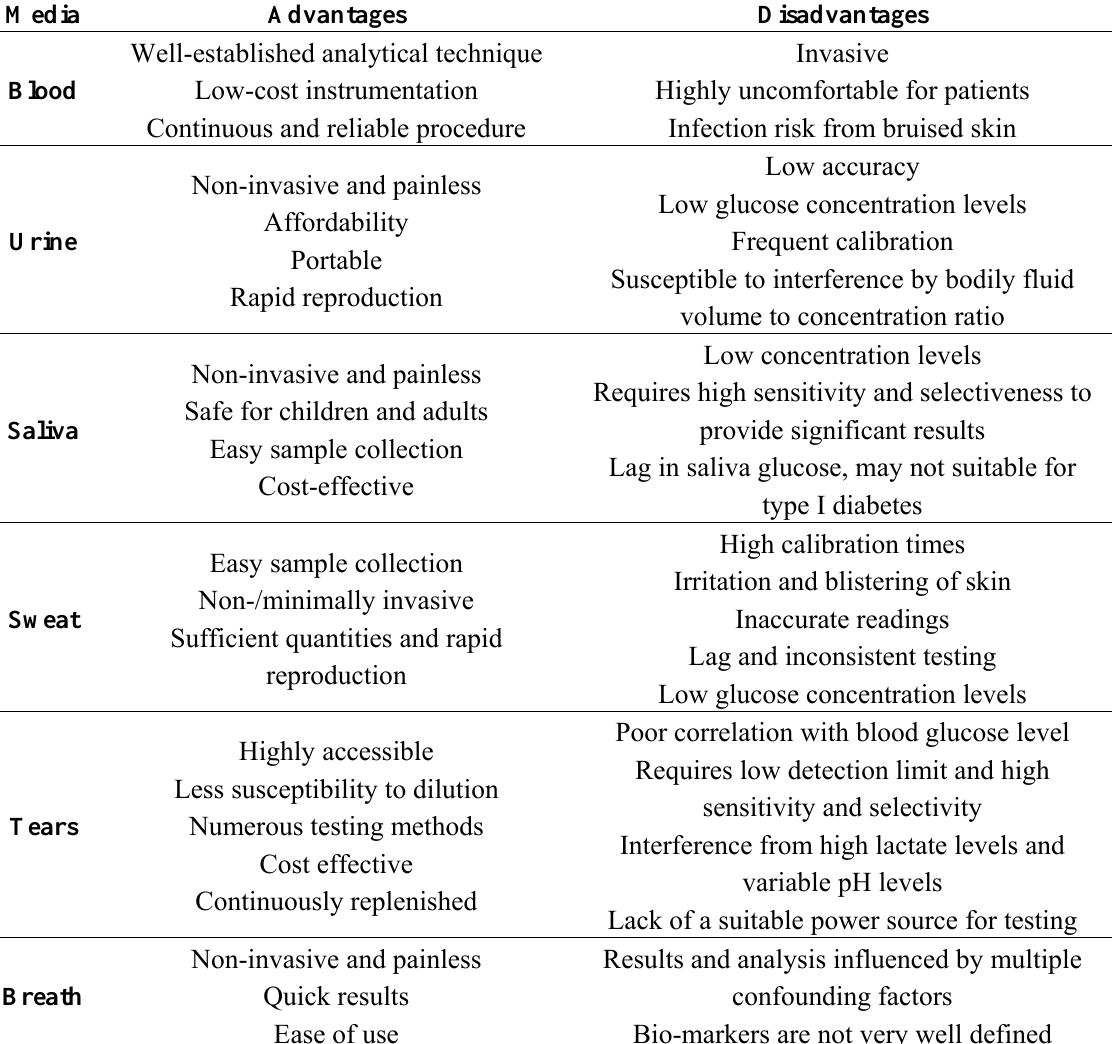
Table 2. The advantages and disadvantages of using various media in diabetes diagnosis.